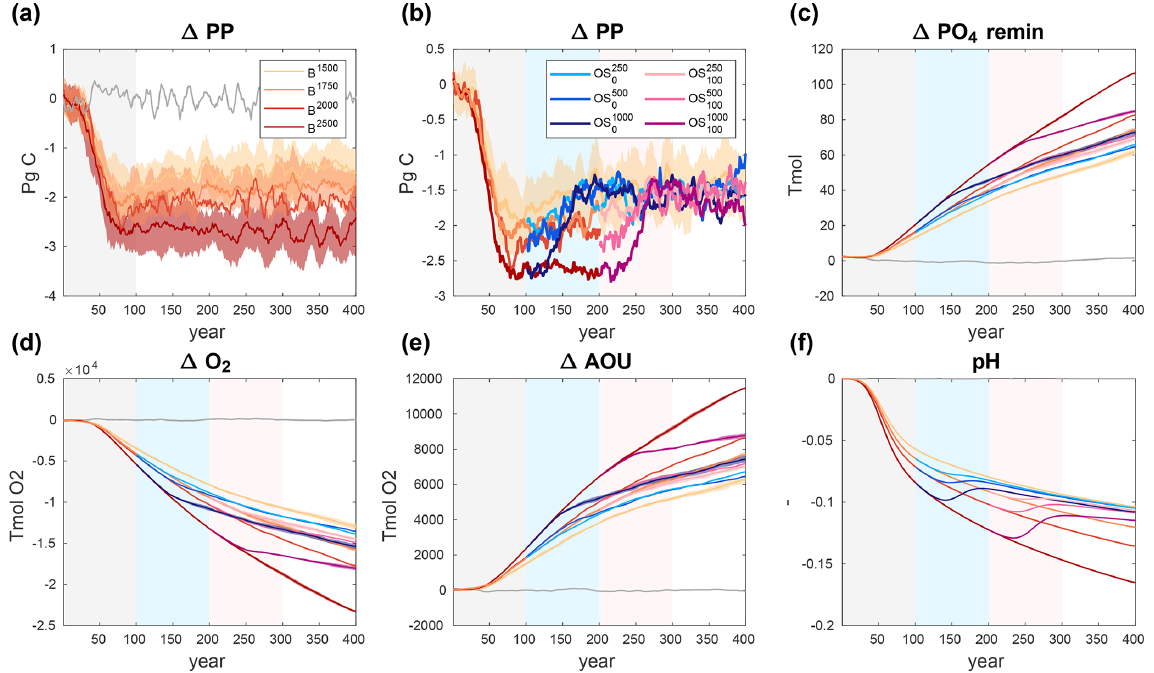
Figure 9. Change in marine primary production (a, b) , change in remineralized phosphate (c) , change in global ocean oxygen content (d) , change in global apparent oxygen utilization (e) , and change in global average pH (f) . For clarity, panel (a) only shows the B simulations, and panel (b) only shows overshoot pathways. The shading around ensemble means indicates an estimate of internal variability as described in the text. An 11-year moving average filter has been applied to all time series. The shaded areas in the background indicate the different phases of the simulations (grey: positive emissions; light blue: negative emissions for the short overshoots; light red: negative emissions for the long